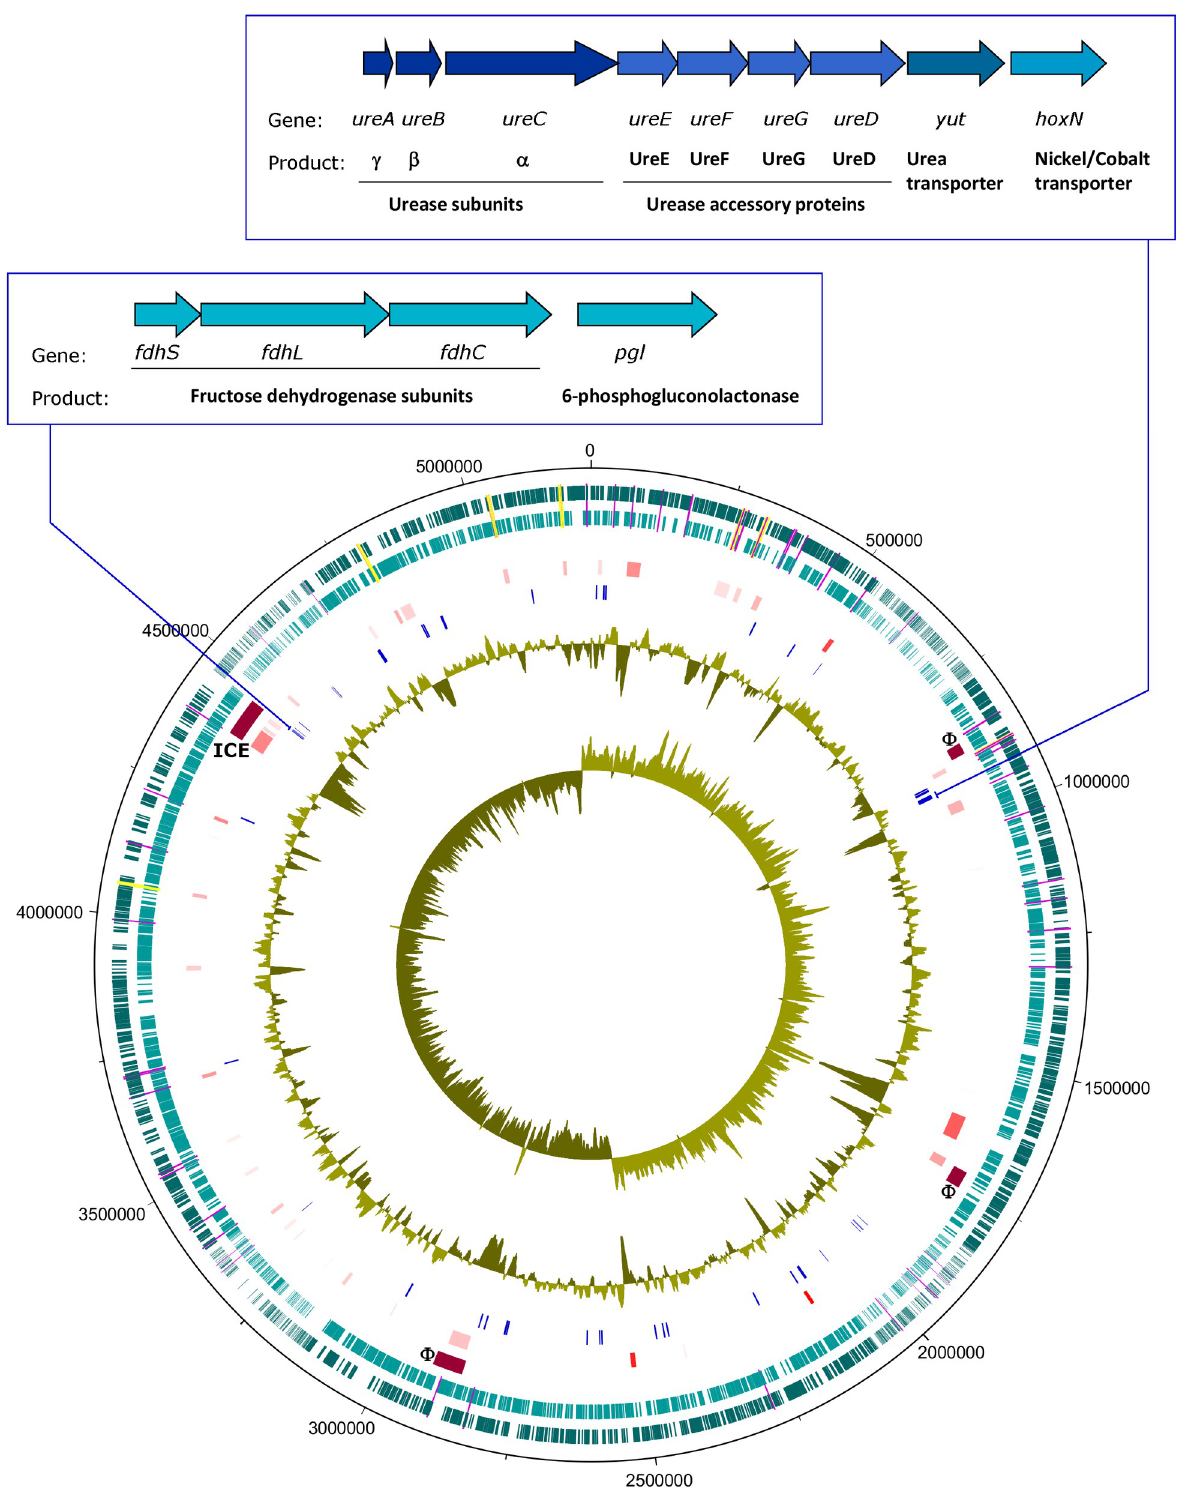
Fig 5. Genome map of strain AM923. This map displays loci that were putatively acquired horizontally and CDSs predominantly found in the genomes of Serratia spp. isolated from insects. Features positioned in concentric circles, from outer to inner tracks as follows: 1–2, dark teal, forward CDSs; light teal, reverse CDSs; mauve, tRNA; yellow, rRNA; 3, dark red, predicted prophages (F), Integrative Conjugative Transposon (ICE); 4, red shades, putative HGT region predicted by Alien Hunter; 5, blue, CDSs predominantly found in insect isolates; 6, G+C%; 7, G+C skew. Inset, map of urease locus (top) and fructose dehydrogenase locus (bottom).